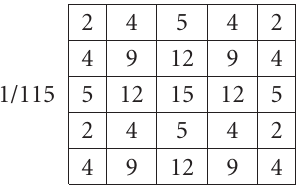
Figure 3.2. Discrete approximation to Gaussian function with σ = 1 . 4.